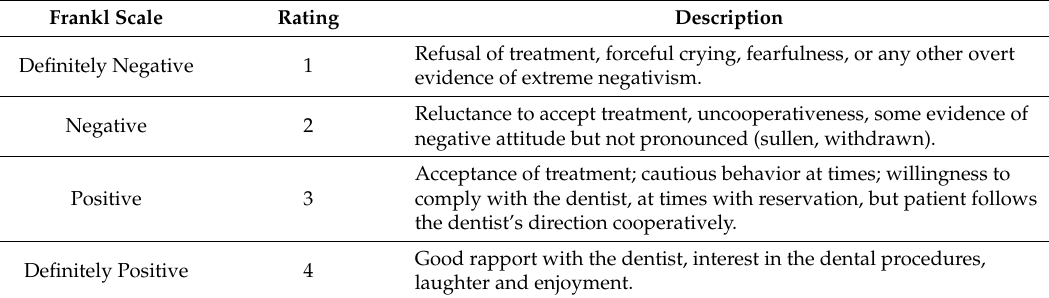
Table 1. Definition of the Frankl